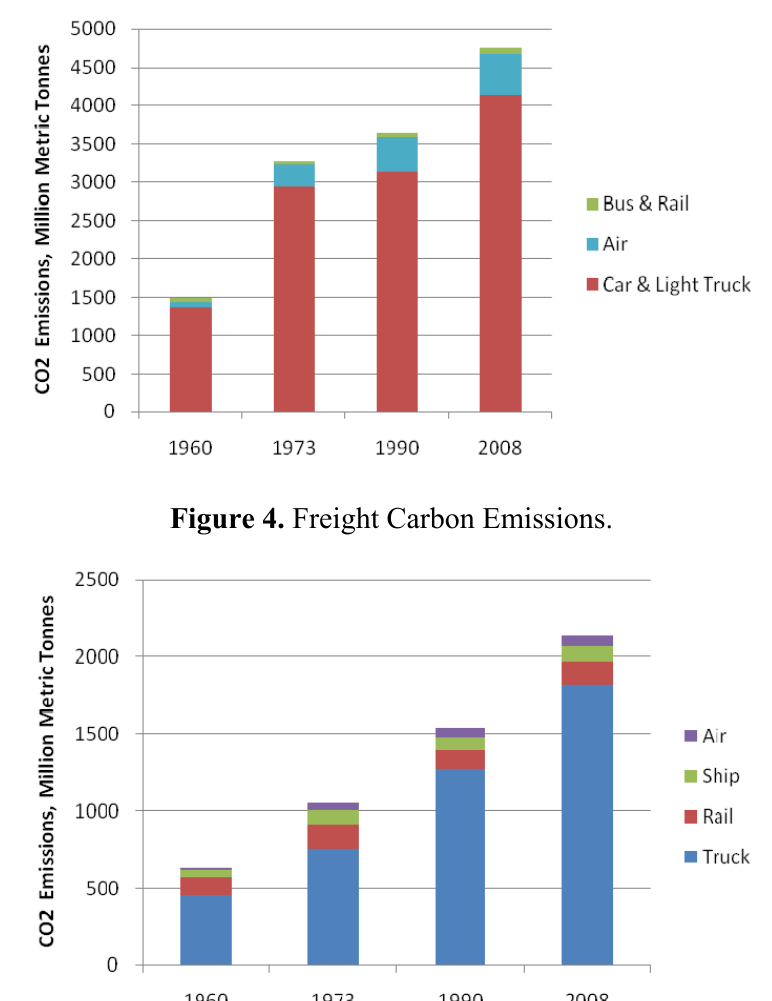
Figure 3. Passenger Travel Carbon emissions.